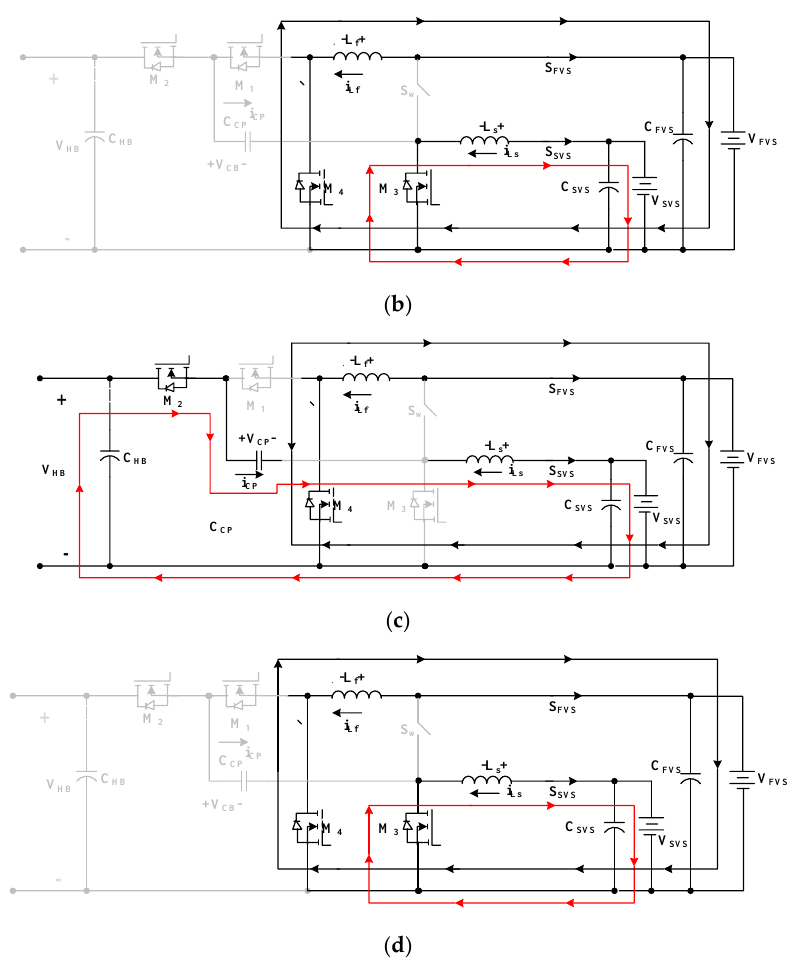
Figure 6. Circuit stages in regenerating mode at high voltage.